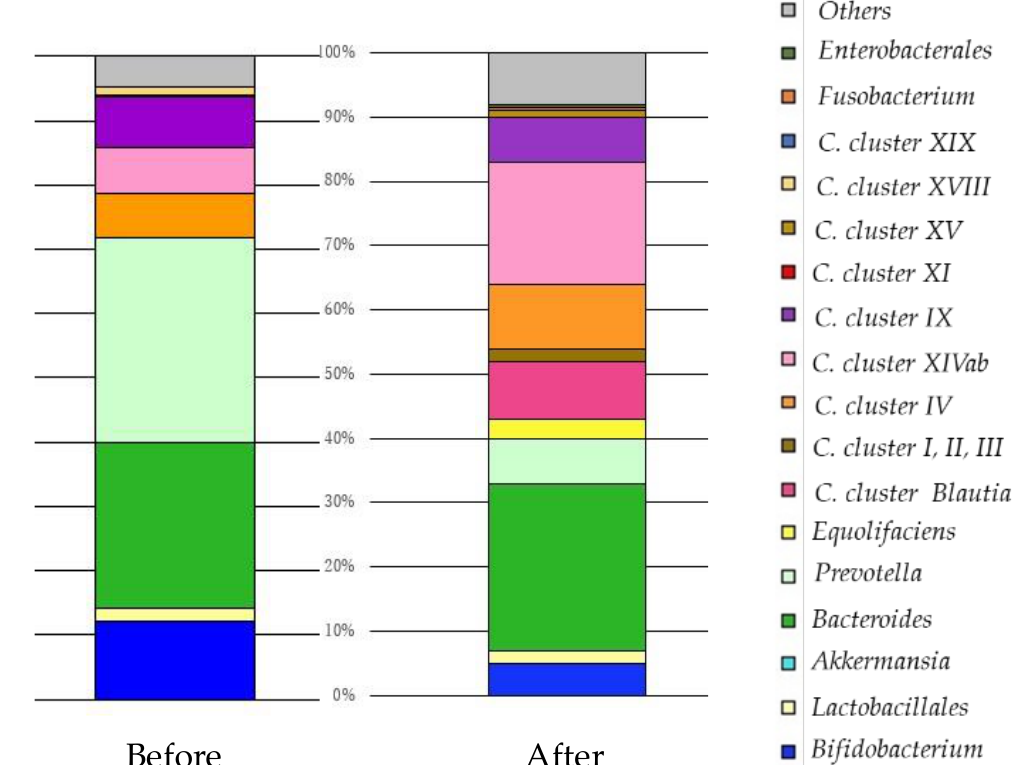
Figure 5. The change in the balance of intestinal microbiota by original profiling of 16SrRNA sequencing before and after FMT in six months. Sixty-six years old, male, lung adenocarcinoma, Stage IV. He received FMT using the bacterial solution adjusted with NanoGAS ® water once a week for six months. No adverse events were observed during the FMT procedure. After FMT, the diversity of intestinal bacteria increased, cluster IX:XIVa improved to 1:2, and immunity was reinforced, resulting in acquisition of tissue repair ability, improvement of glucose, and lipid metabolism. As a result, his QoL and prognosis improved. He survived approximately one year after six months of FMT. Clostridia (C.)